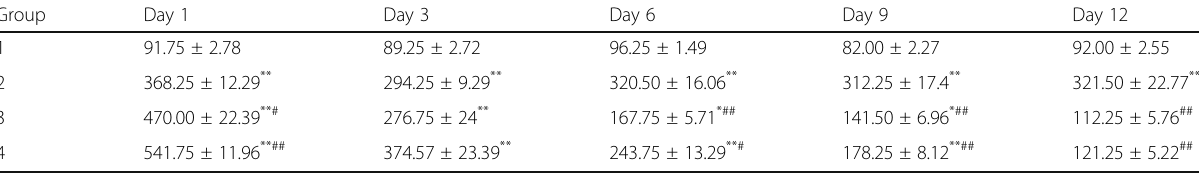
Table 3 Effects of HIE treatment on fasting blood glucose in streptozotocin induced diabetic mice Group